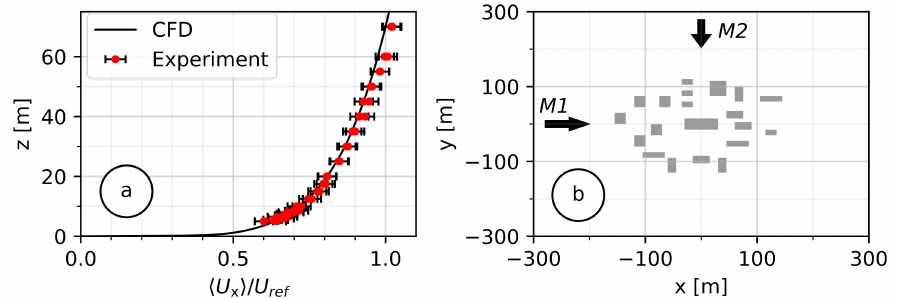
Figure 6. ( a ) Comparison of the boundary layer flow measured in the wind tunnel and calculated with the presented model; ( b ) schematic representation of the obstacle configuration and the approach flows M1 and